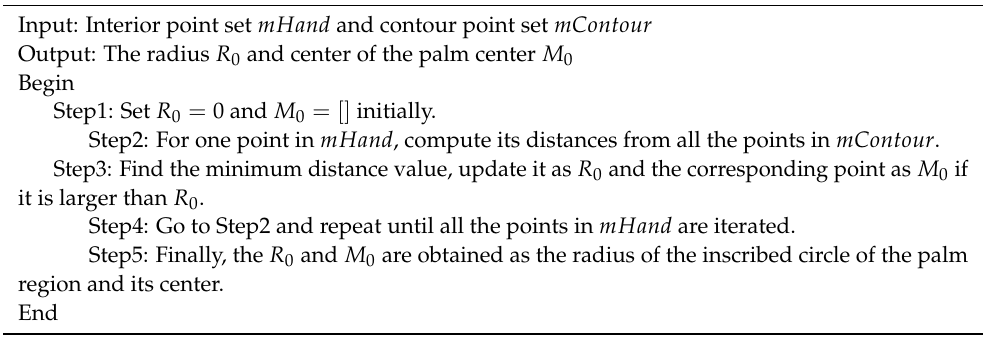
Algorithm 1 Calculating the center and maximum radius of the palm region